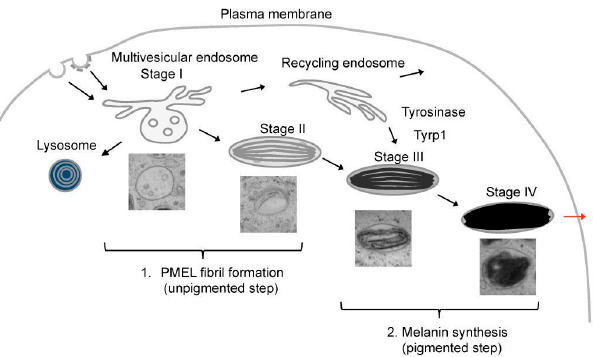
Figure 1. Schematic representation of melanosome biogenesis. The different stages of melanosomes are illustrated by electron microscopy pictures. Melanosome biogenesis is initiated in multivesicular endosomes, also called stage I melanosomes, where PMEL fibrils start to assemble. In stage II melanosomes, PMEL fibrils give the melanosomes their characteristic ellipsoidal shape and striated appearance. Both stage I and stage II melanosomes are unpigmented. Melanin starts to be produced in stage III melanosomes, to which melanin synthesizing enzymes, such as Tyrosinase or Tyrp1, are transported. Melanin is sequestered on PMEL fibrils, which become completely masked by melanin in stage IV melanosomes. In skin, mature stage IV melanosomes are transferred to keratinocytes (red